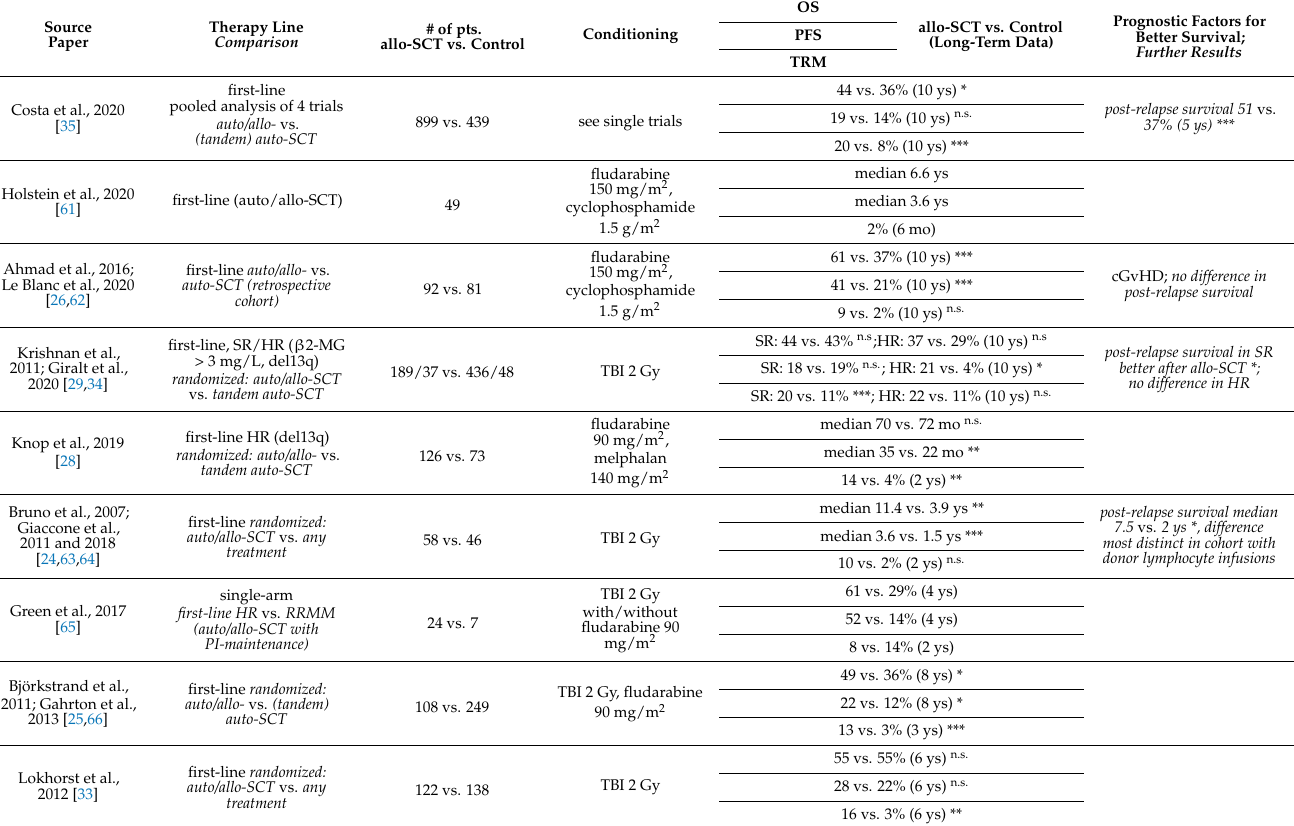
Table 1. Overview of prospective trials on allo-SCT in